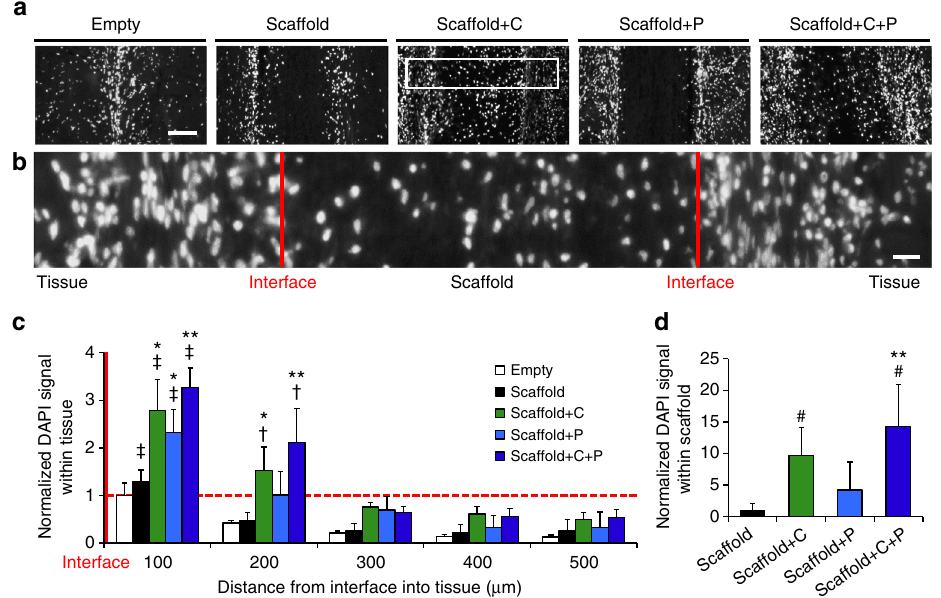
Fig. 6 Scaffolds releasing collagenase and PDGF-AB increase interfacial cellularity. a Images of DAPI-stained nuclei (white) at the center of repair constructs after 4 weeks of subcutaneous implantation. Interface is in the middle. Scale = 100 µ m. b Magni fi ed image from white box in a . Red lines indicate tissue-scaffold interfaces. Scale = 20 µ m. c Average cell signal intensity with respect to distance from the interface, normalized to the Empty value at the interface and d average cell signal intensity within the scaffold center (300 µ m thickness), normalized to the control Scaffold group ( n = 4 – 5 samples/group, mean ± s.d.). † = p < 0.05 vs. distances ≥ 300 um, ‡ = p < 0.05 vs. all other distances, # = p < 0.05 vs. Scaffold, * = p < 0.05 vs. Empty and Scaffold, ** = p < 0.05 vs. Empty, Scaffold, and Scaffold +